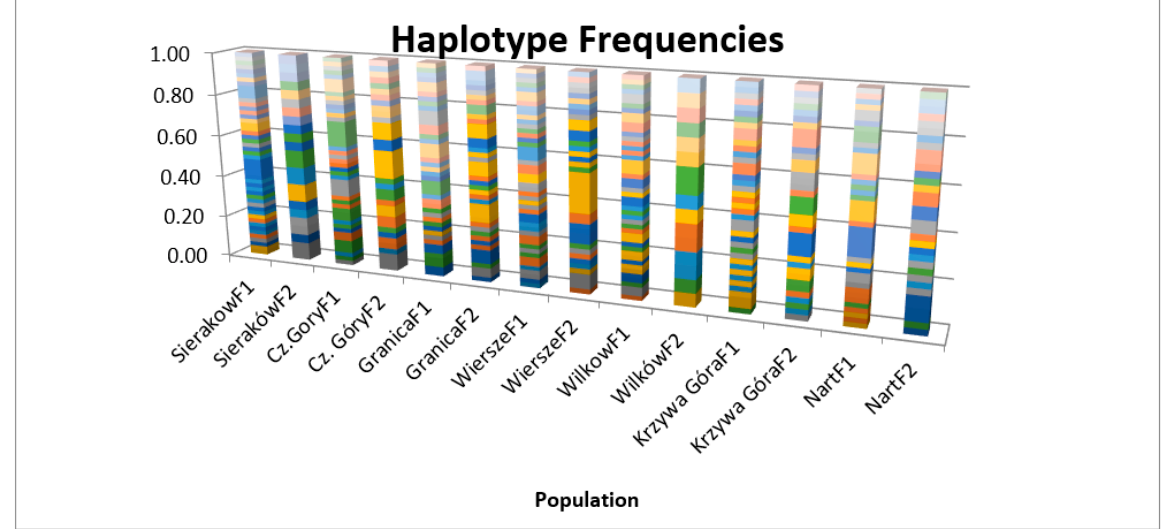
F1 and particularly high for Sierak ó w (4.29) and Wiersze (5.52), which were not maintained for F2 (Table 2).